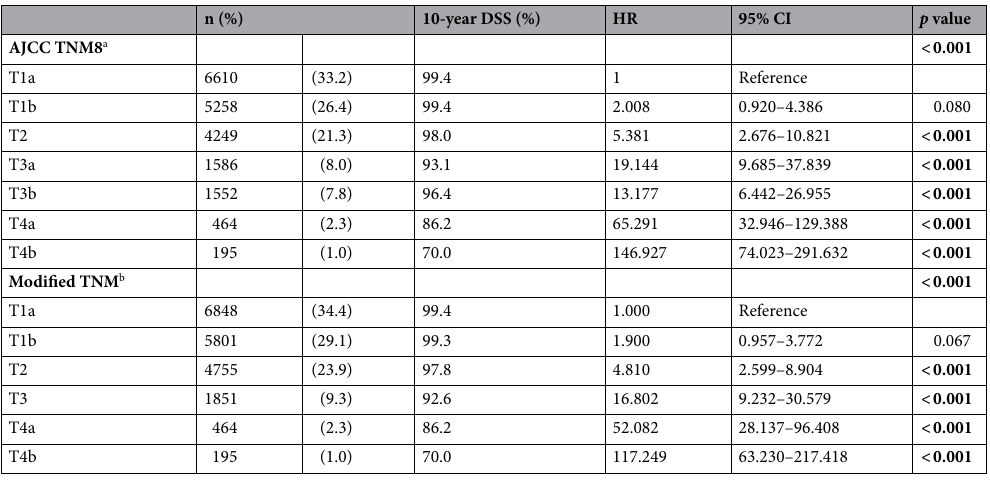
Table 2. 10-year DSS and T stage distribution according to the AJCC 8th TNM staging schema or modified TNM staging schema (n = 19,914). Statistically significant values are shown in bold. DSS disease-specific survival, HR hazard ratio, CI confidence interval. a Staging according to the American Joint Committee on Cancer (AJCC) 8th edition of TNM classification. b Staging according to the suggested modified TNM staging schema discarding the strap muscle invasion factor from the T staging